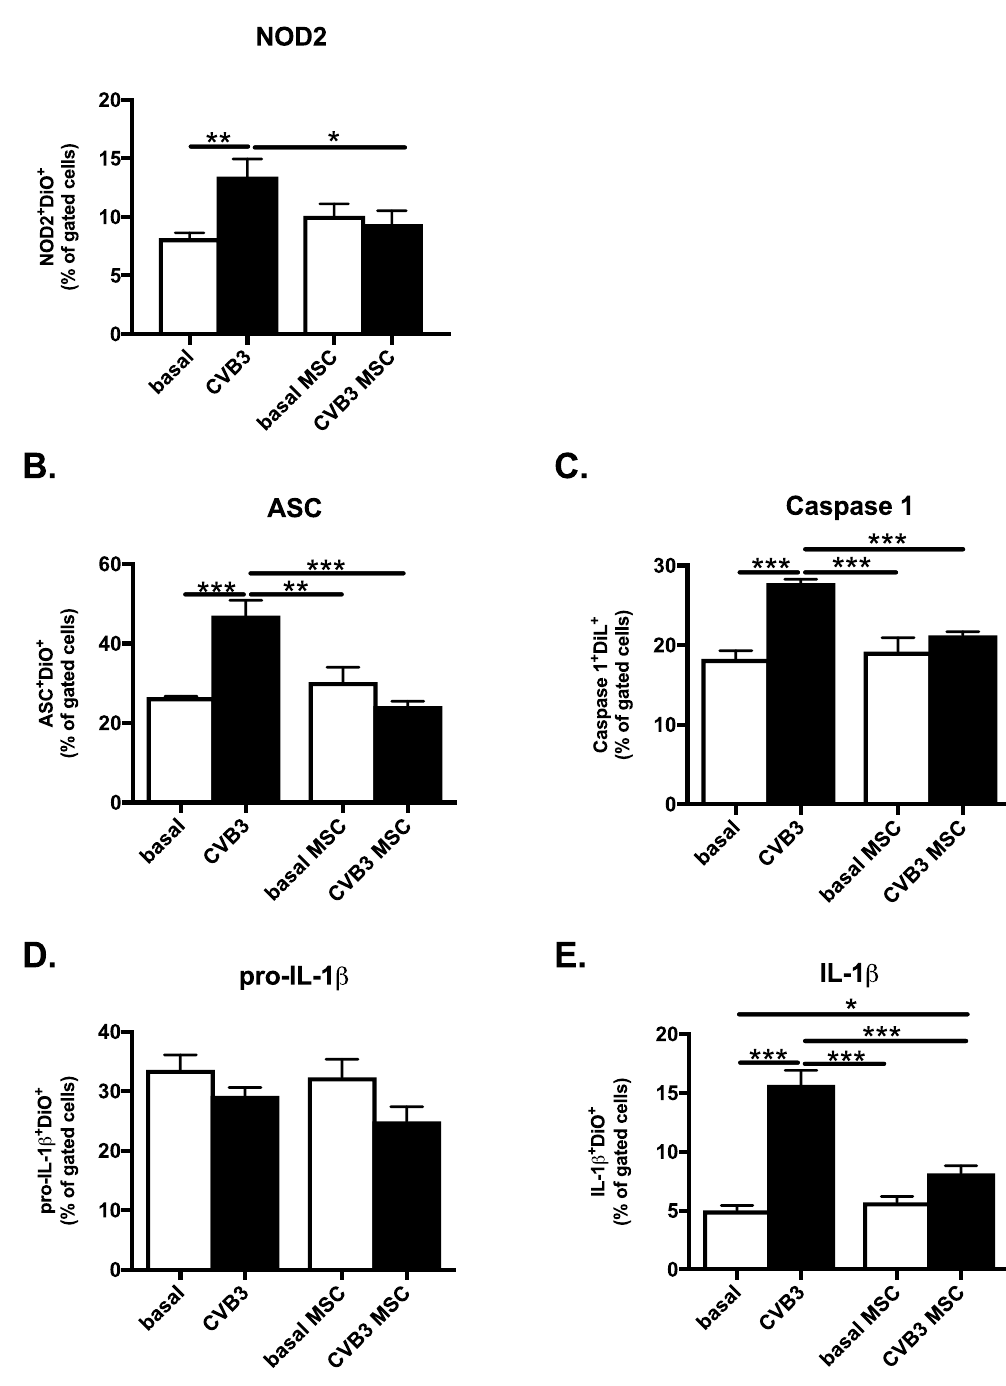
Figure 2. Mesenchymal stromal cells suppress NOD2 expression and NLRP3 inflammasome activation in Coxsackievirus B3-infected cardiomyocytes. Bar graphs represent the mean ± SEM of ( A ) NOD2 + /DiO + , ( B ) ASC + /DiO + , ( C ) Caspase 1 + /DiL + , ( D ) pro-IL-1 β + /DiO + and ( E ) IL-1 β + /DiO + cells cells depicted as the % of gated cells of basal or MSC (open bars) or CVB3-infected (closed bars) HL-1 cardiomyocytes with or without MSC, as indicated with n = 5–6/group, * p < 0.05, ** p < 0.01 and *** p <